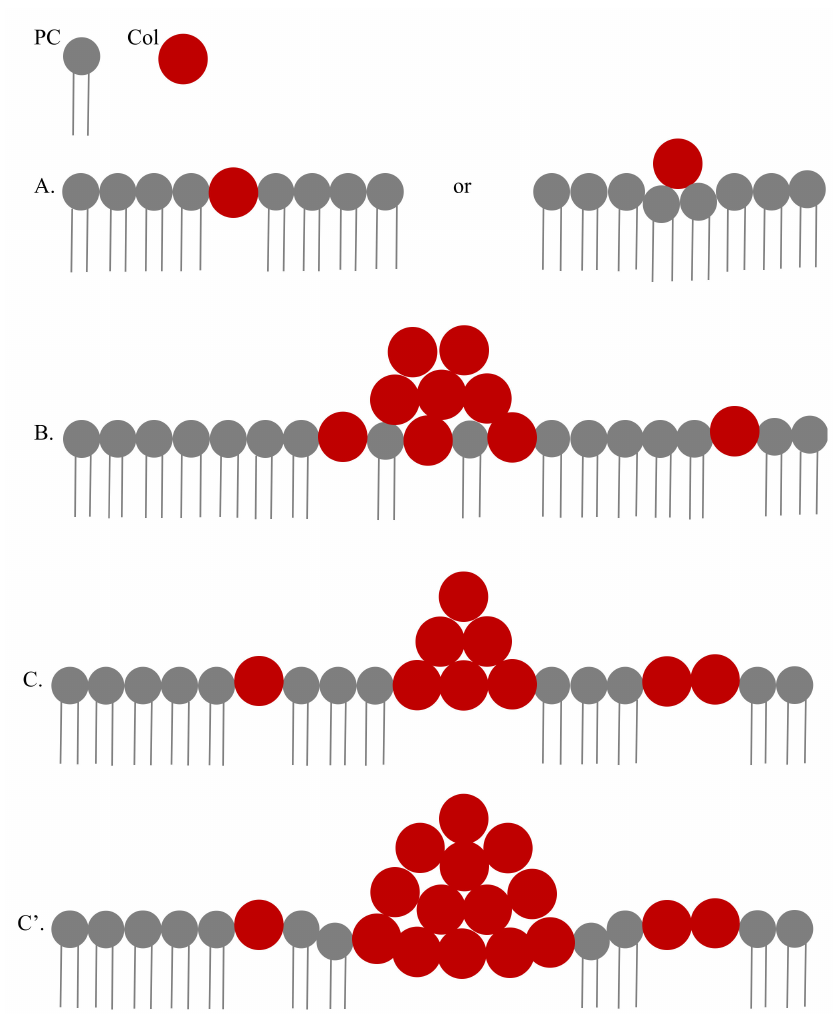
Figure 8. The distribution of drugs on the cell surface has been modeled. ( A ) Top panel demonstrates the single drug adsorption on the cell surface what we brand as the drug in the lipid cluster (right side confirmation is also supported due to lipid membrane elasticity [4] which ensures modest lipid monolayer bending before actually breaking or rearranging the structure as shown in left side). ( B , C , C’ ) demonstrate the creation of drug clusters on the cell surface. ( B ) shows that the drugs and lipids may coexist inside cluster in its 2D base (cross-sectional view over one lipid layer is shown here) aligned with the surface of the membrane monolayer, whereas ( C ). suggests that the drug cluster expels lipids totally, the scenario we have branded as drugs in drug clusters. Drug clusters in both distinguishable conditions presented in ( B , C , C’ ) may push the monolayer a bit towards the hydrophobic membrane core, depending on the amount of downward acting gravity which is predicted (not calculated here) to be higher for larger clusters (see ( C’ )). ( C , C’ ) represent identical conditions, except the latter representing a bit bigger than the former cluster. The different types of drug clustering may also concomitantly exist on different locations of the cell surface. As both drugs and lipids are continuously dynamic with the time scale of molecular movement of the order of millisecond (ms) or less (maybe considered equivalent to the ion pore stability as detected in various studies including e.g., in [8,24]), the whole process follows principles of Statistical Mechanics. For simplicity, we have just sketched a lipid monolayer although cell membrane is a lipid bilayer. However, it is also true that while penetrating into the cell through lipid membrane from cell surface drugs face cell surface lipid monolayer, as we have modeled here. The CD-induced pore formation certainly involves both monolayers (models are presented in